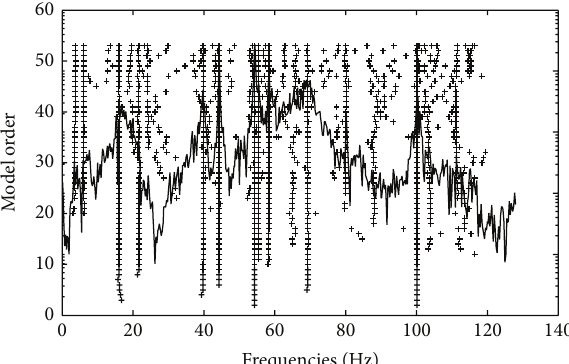
Figure 3: The aircraft stabilization diagram with only preliminaries